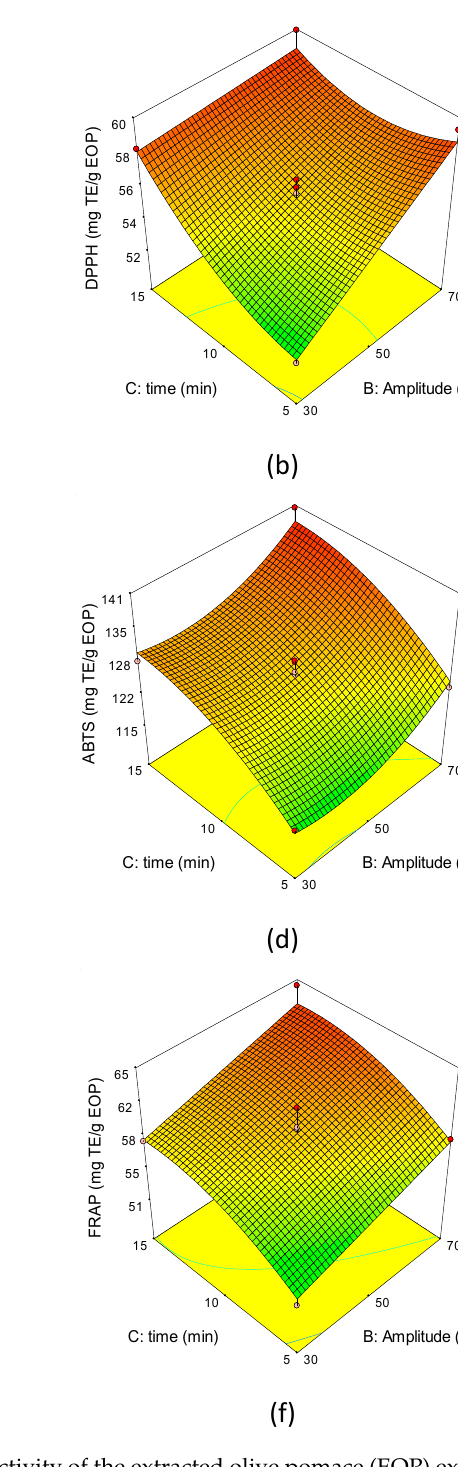
Figure 4. Response surfaces of the antioxidant activity of the extracted olive pomace (EOP) extracts. (a), (b) DPPH assay; (c), (d) ABTS assay; and, (e), (f) FRAP assay.